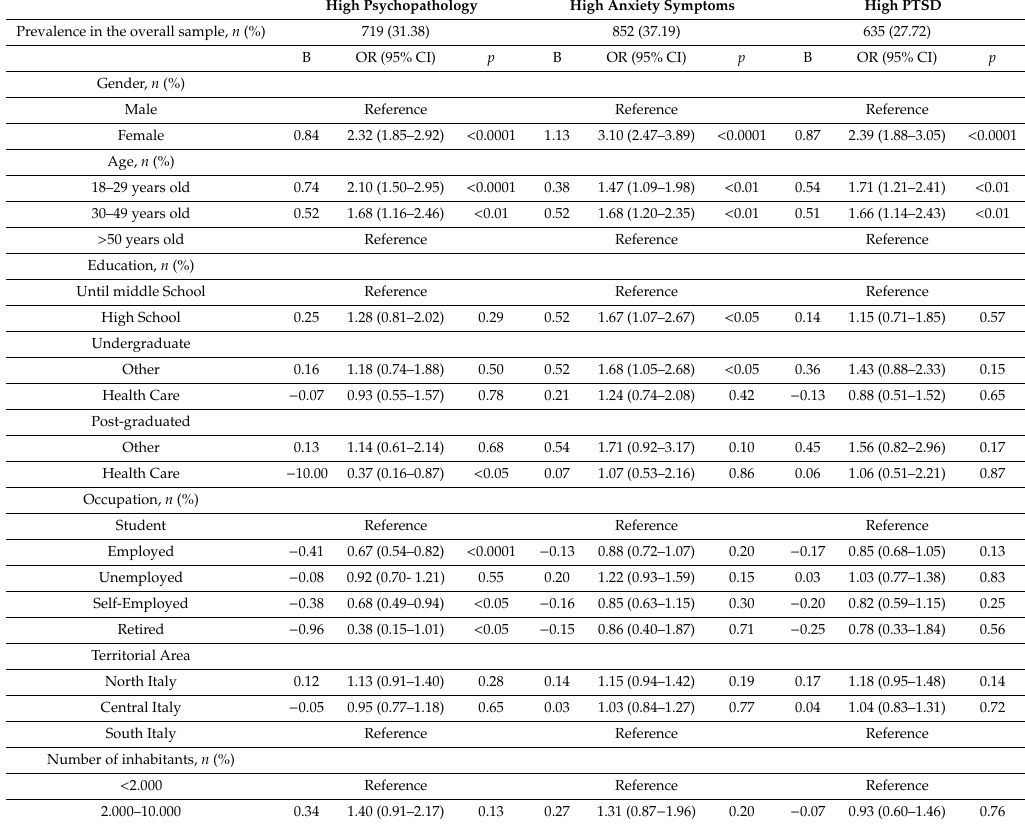
Table 5. Results of logistic regression analyses. HighPsychopathology